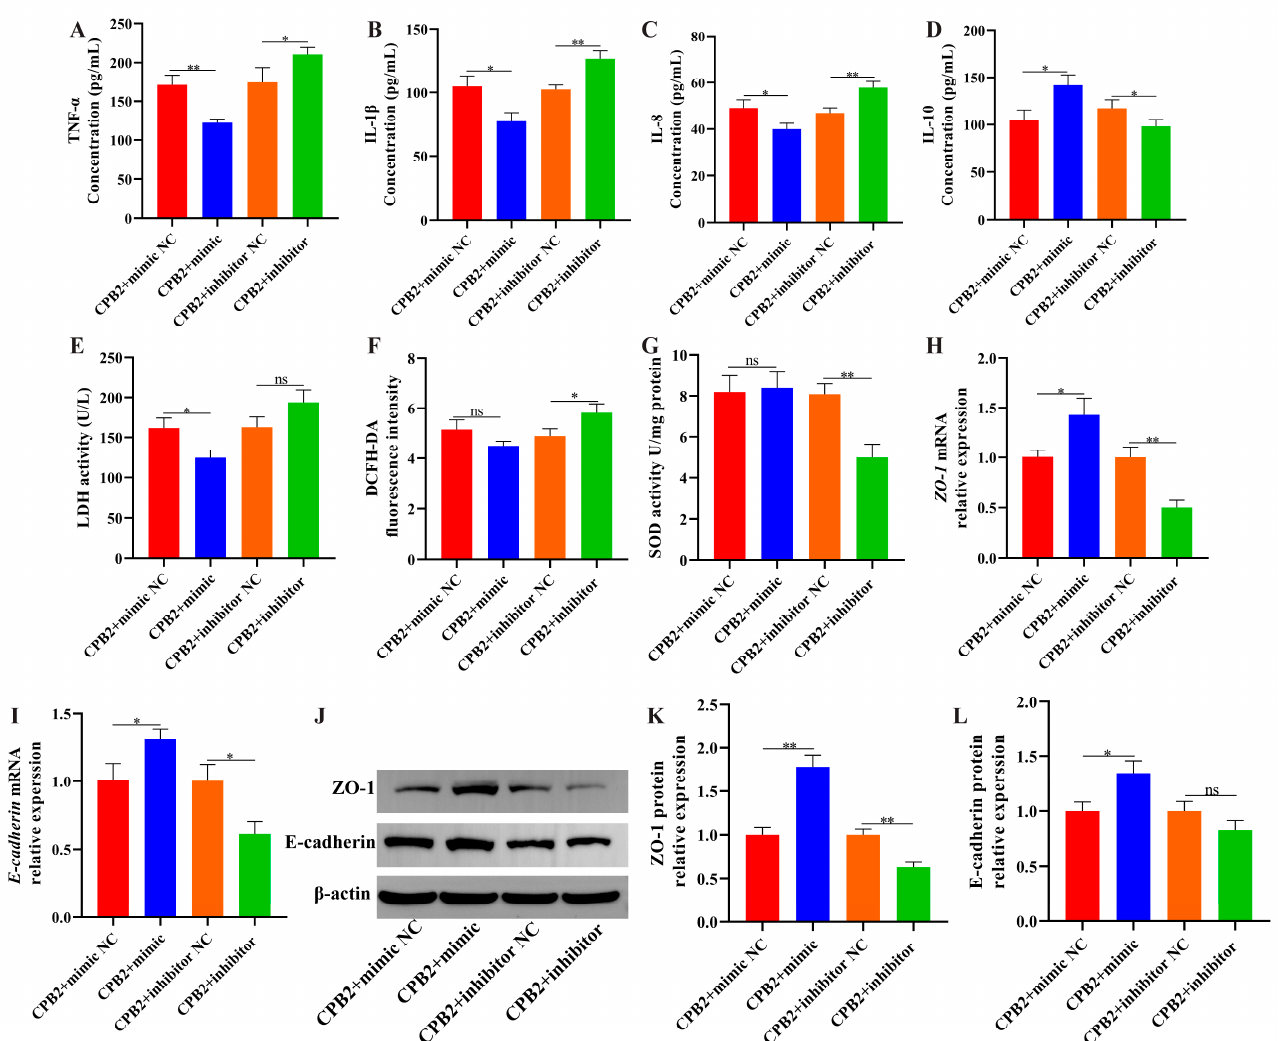
Figure 7. Elevated ssc-let-7i-5p ameliorated IPEC-J2 inflammatory damage and barrier dysfunction induced by CPB2 toxin. ( A – D ) TNF- α , IL-1 β , IL-8 and IL-10 levels via ELISA. ( E ) LDH activity. ( F ) ROS level. ( G ) SOD activity. ( H – I ) ZO-1 and E-cadherin mRNA expression through RT-qPCR. ( J – L ) ZO-1 and E-cadherin protein expression through Western blot. ns: not significant. * p < 0.05, ** p < 0.01.